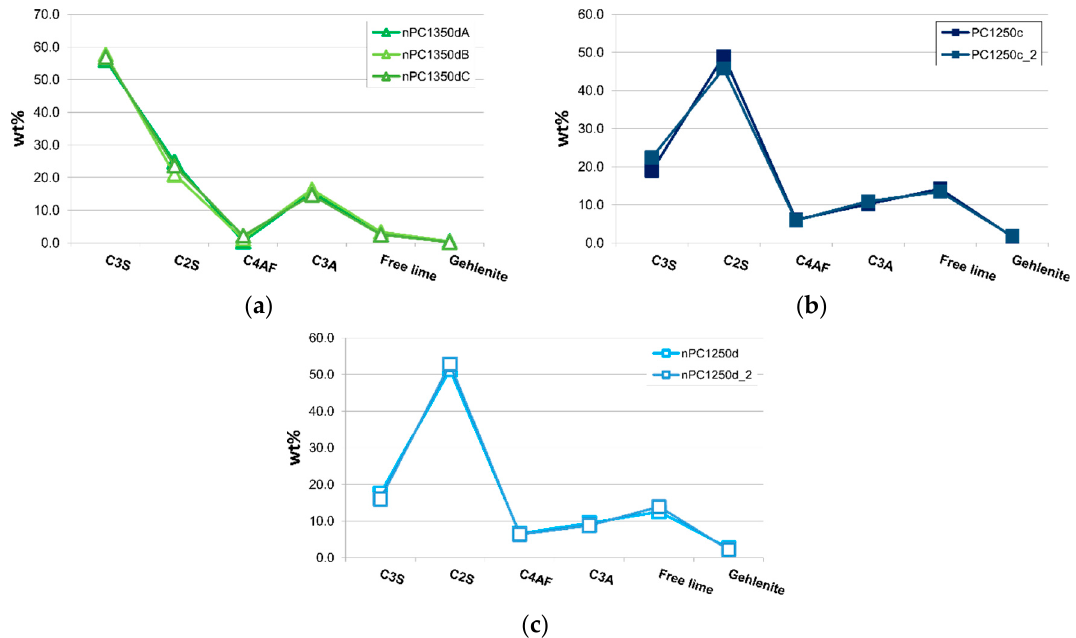
Figure 8. Spider diagrams of ( a ) nPC1350dA, nPC1350dB, and nPC1350dC and ( b ) PC1250c and PC1250c_2 and ( c ) nPC1250d and nPC1250d_2. Error bars in wt % are within the symbols. The CaO + Ca(OH) 2 content is expressed as “Free lime.”